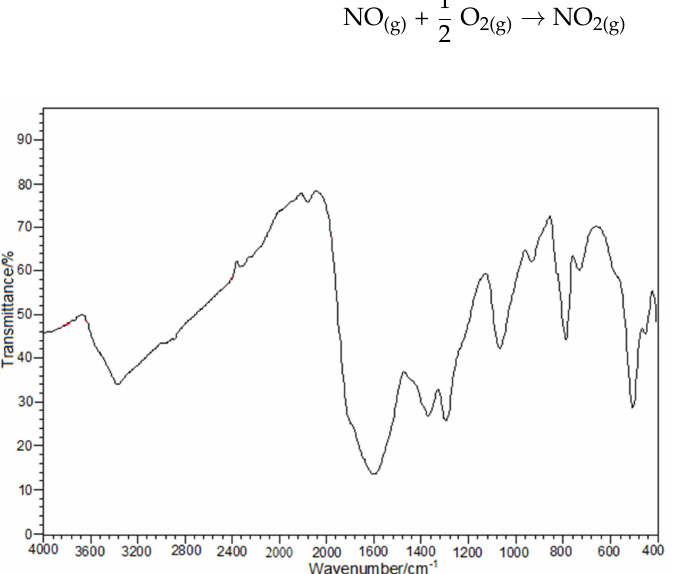
Figure 1. The IR vibrational spectrum of Bi 2 Cu(C 2 O 4 ) 4 · 0.25H 2 O compound.